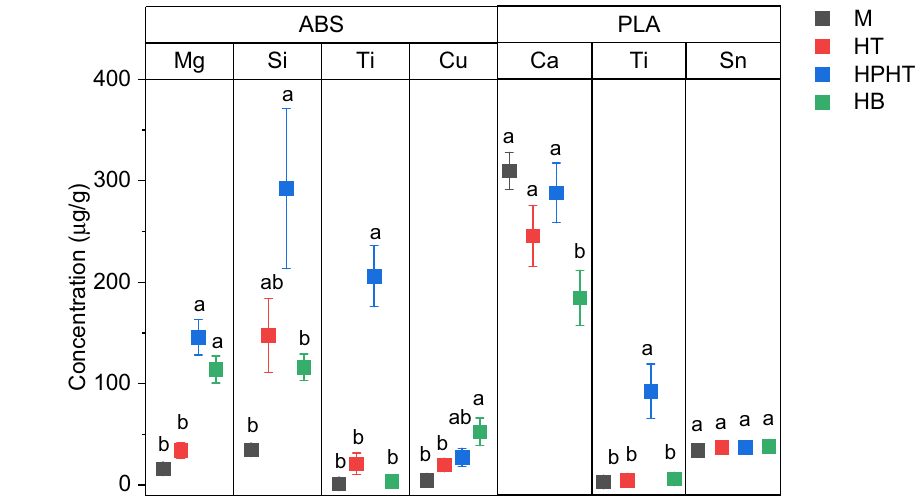
Fig. 1 Concentration of ele- ments recovered from ABS and PLA plastics as a function of the digestion method. Error bars are equal to the standard error calculated in the ANOVA. Lower case letters correspond to the results from the Tukey Means pair wise comparison. A difference in letters indicates a statistical difference in the mean concentration of an ele- ments extracted at an α =